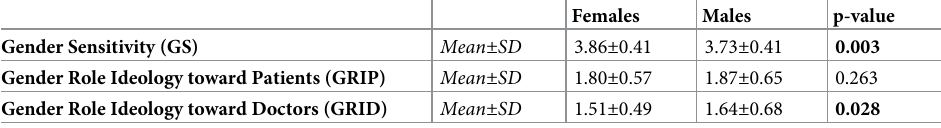
Table 2. Stereotypes in gender medicine: Gender sensitivity (GS), role ideology toward patients (GRIP) and role ideology towards doctors